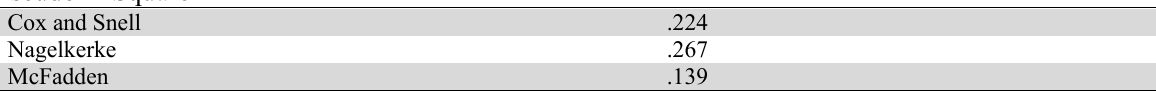
Pseudo R-Square Cox and Snell .224 Nagelkerke .267 McFadden